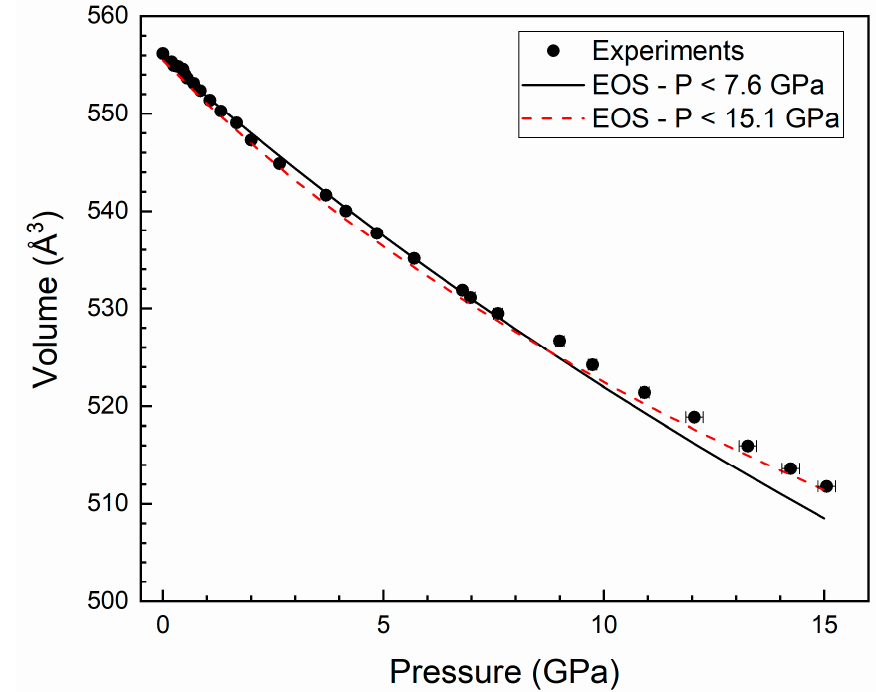
Figure 7. Pressure dependence of the unit-cell volume of Ni 3 V 2 O 8 . Solid circles are obtained from experiments. Where not shown, error bars are comparable to symbols’ size. The black solid (red dashed) line is the equation of state obtained from data for P ≤ 7.6 (15.1) GPa. As stated in the text, results deviate from the quasi-hydrostatic EOS for P ≥ 7.6 GPa likely due to the influence of non- hydrostaticity.